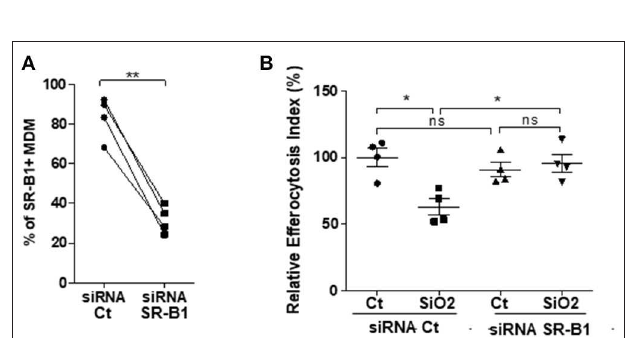
FIGURE 4 | Impairment of efferocytosis by silica in MDM requires SR-B1 expression. M0 MDM from the same healthy donors, were transfected with siRNA Ct or siRNA for SR-B1 for 24h. Percentages of SR-B1 positive MDM (A) and EI of MDM from the same 4 healthy donors (B) , untreated or treated to SiO 2 and then exposed to apoptotic Jurkat (apoJ) or live Jurkat (J) cells for 90min, were both determined by flow cytometry (Experiment on MDM from 4 different healthy donors). * p < 0.05; ** p < 0.01; ns, not